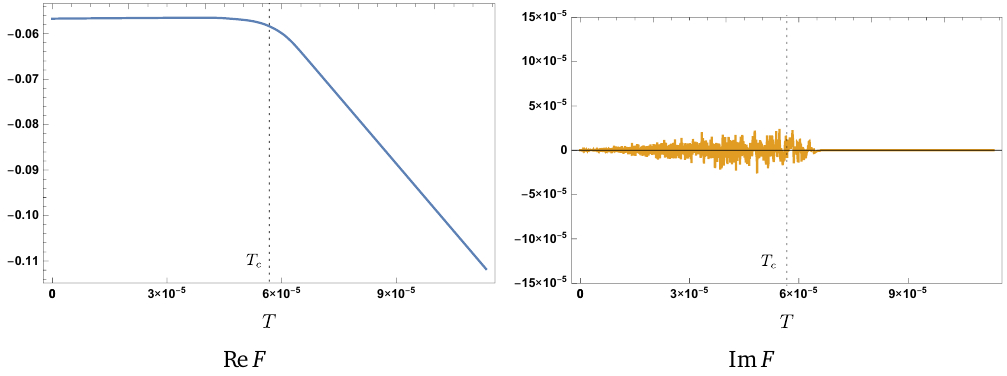
Figure 8: Quenched average over 100 realization of j ( τ ) in the first ensemble (55). The parameters used for the plot are k = 1, S the imaginary part is adapted for one realization so that we see that it averages to zero. T is defined as the mean of the critical temperatures of the different realiza- c